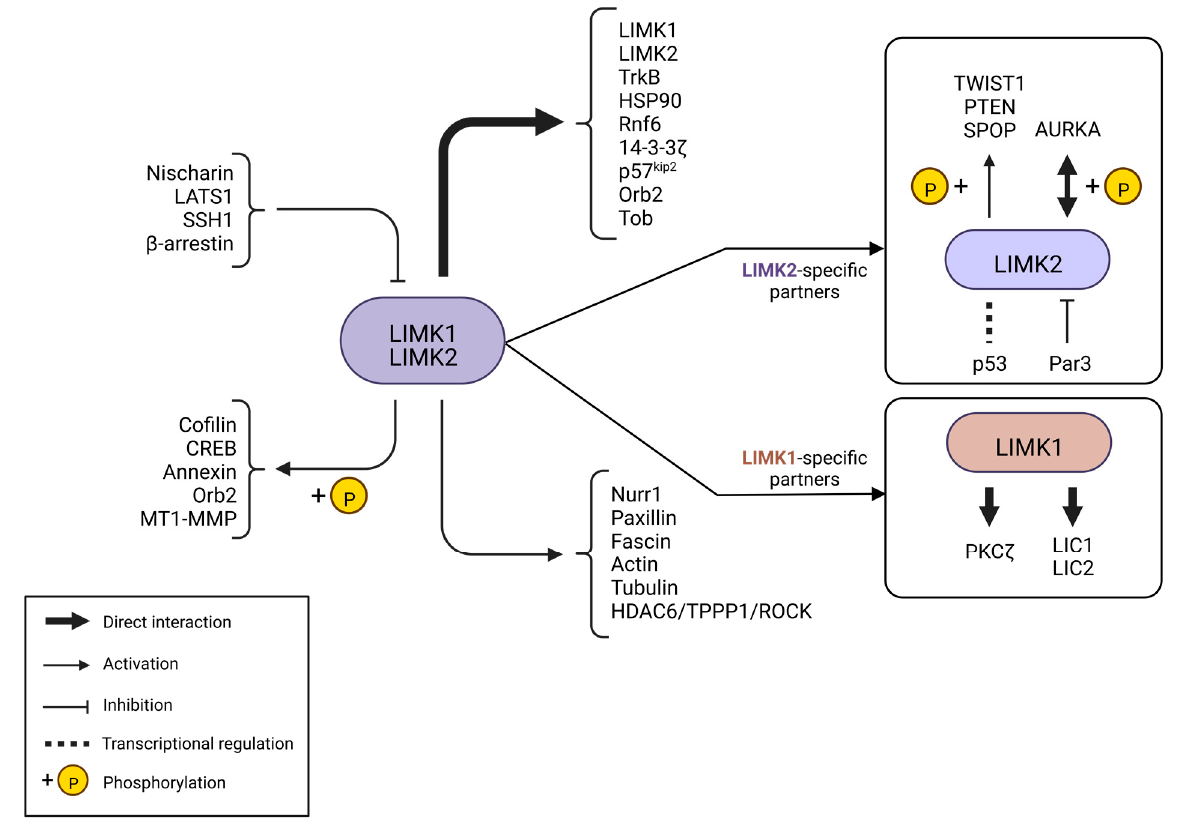
Figure 4. Partners of LIM kinases.